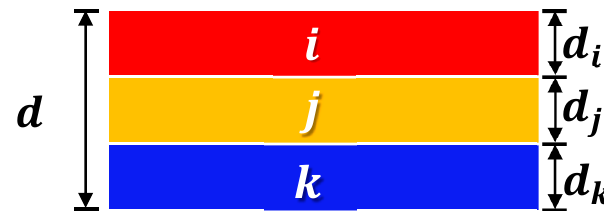
Figure 1. Schematic diagram of the multi-layered fiber preform.